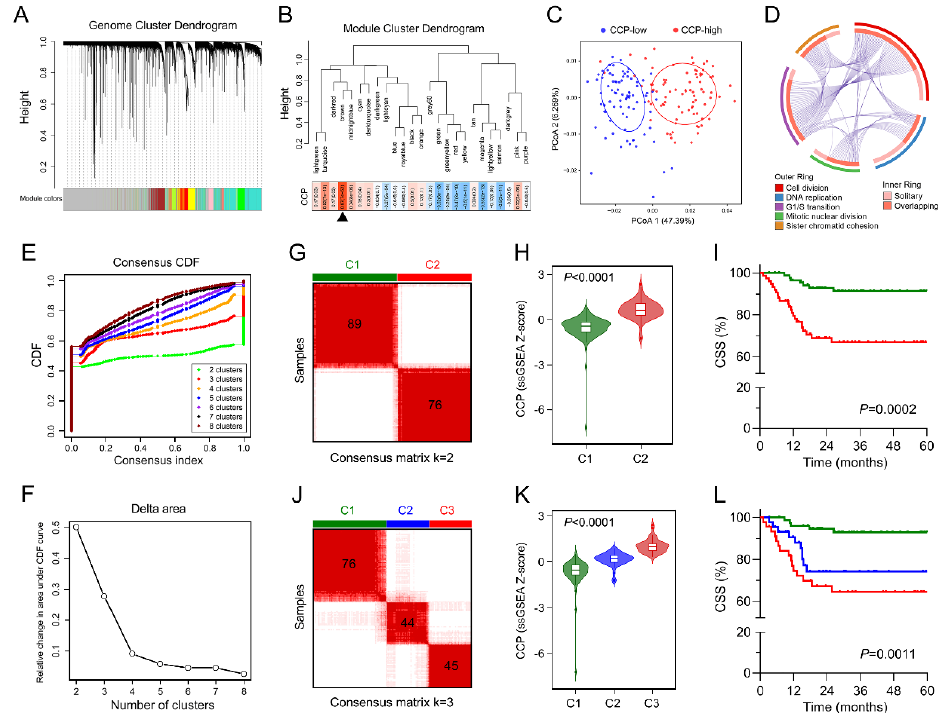
Figure 3. Identification of a CCP-related gene module. ( A ) Weighted correlation network analysis (WGCNA) was performed with transcriptome profiling data and CCP ssGSEA Z-scores in the training set. ( B ) The brown module depicting the highest correlation (r = 0.87, p = 7e–52) with CCP ssGSEA scores was considered as “CCP module”. ( C ) Principal coordinates analysis (PCoA) was performed to visualize the dissimilarity of CCP-low and CCP-high samples based on the Bray–Curtis distance matrix. ( D ) Circos plot demonstrated that all of five most significant processes were labelled with cell cycle-related features. ( E ) Based on expression pattern of genes involved in the brown module, K-means-based consensus clustering was performed to classify the training group into different subgroups. Cumulative distribution function (CDF) plot showed the cumulative distribution functions of the consensus matrix for each k (from 2 to 8, indicated by colors). ( F ) The difference between two CDF curves (k and k-1) is illustrated by measuring the area under the CDF curves from k = 2 to 8 in the delta area plot. ( G , J ) k = 2 and 3 were chosen as optimal parameters to divide the training cohort into different subgroups. ( H , K ) Violin plots showed that CCP ssGSEA scores were di ff erentially distributed in identified subgroups. (I , L ) Patients exhibited di ff erent CSS in identified